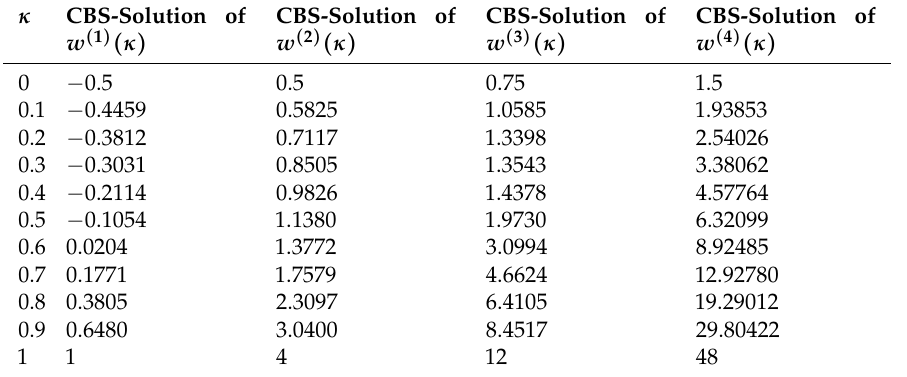
Table 4. Errors at derivatives where boundary conditions (BCs) are defined in problem 1 at h = 1